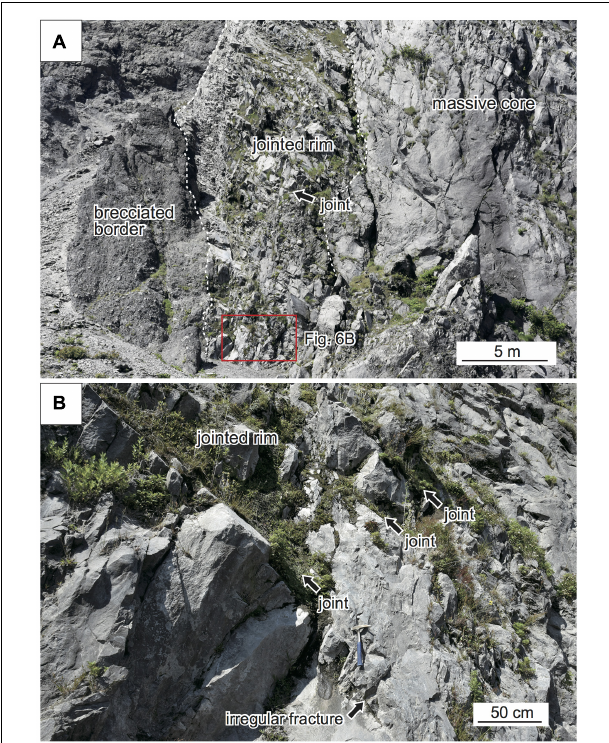
FIGURE 6 | (A) Photograph of the jointed rim of the Ogariyama dome, which occurs between the massive core and brecciated border. The location of (B) is indicated by the red rectangle. (B) Close-up view of the jointed rim, which contains numerous rectangular and parallel joints, as well as irregular fractures.